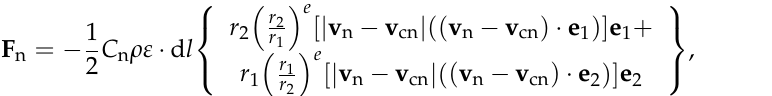
The normal drag F n is given by